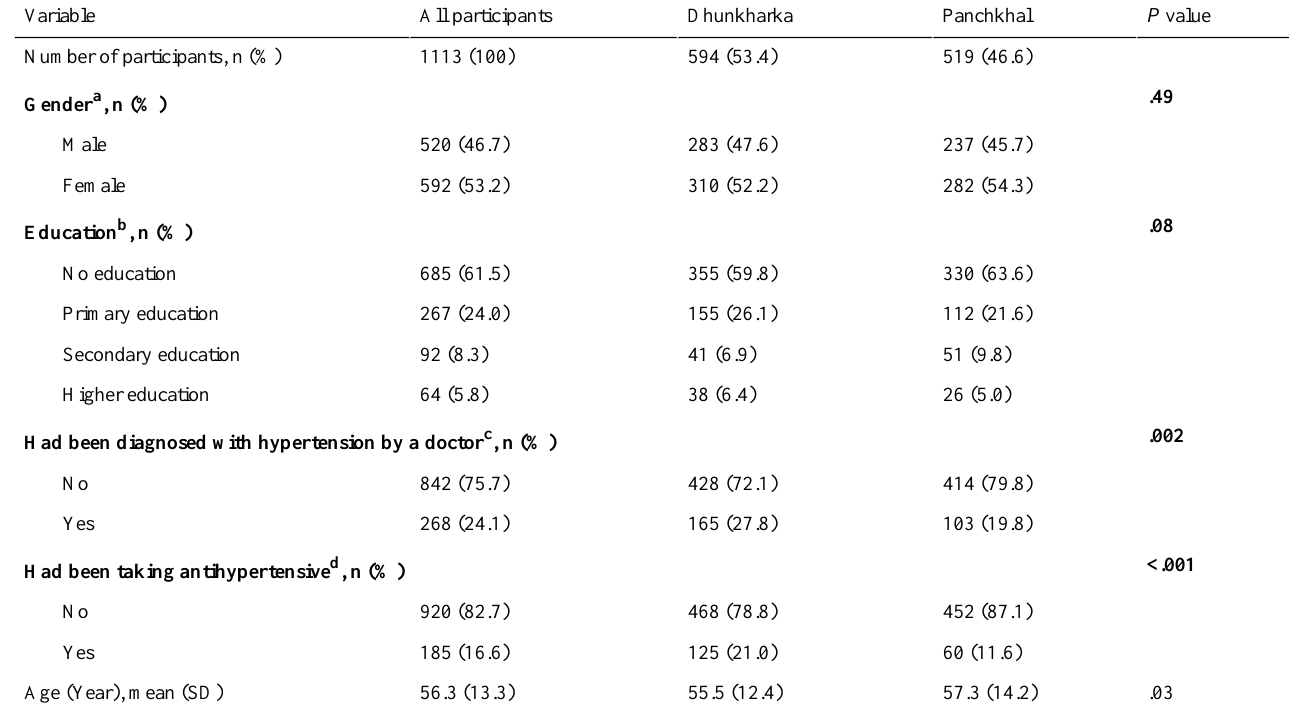
Table 1. Baseline characteristics of the sample in Phase II at